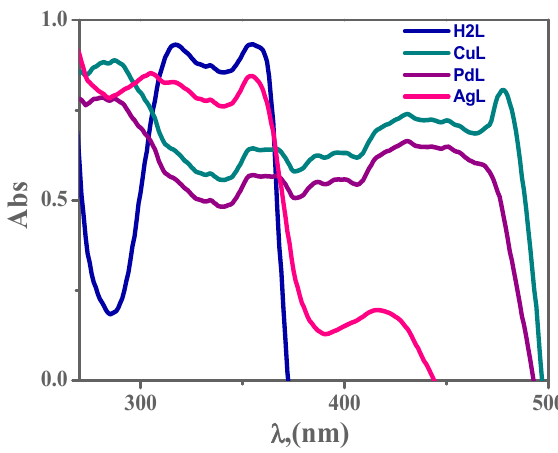
Figure 2. The electronic scans of 1 × 10 − 3 M H 2 L ligand and its metal complexes in dimethylformamide (DMF) at 298 K.